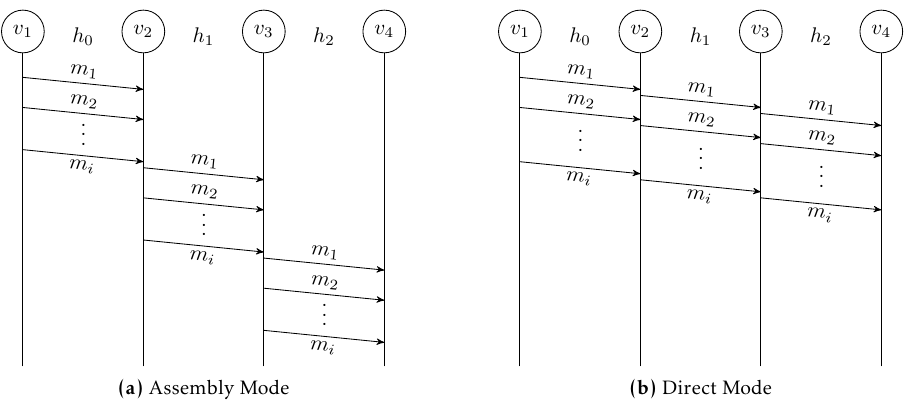
Figure 1. Illustration of message flow in Assembly Mode and Direct